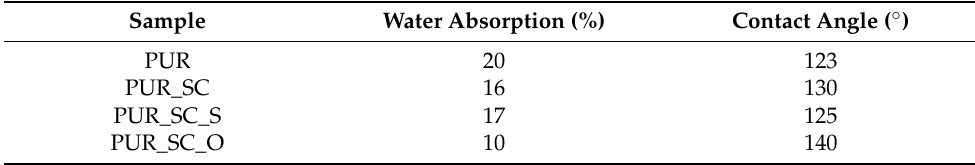
Table 3. The impact of SC fillers on water absorption and contact angle of PUR composite